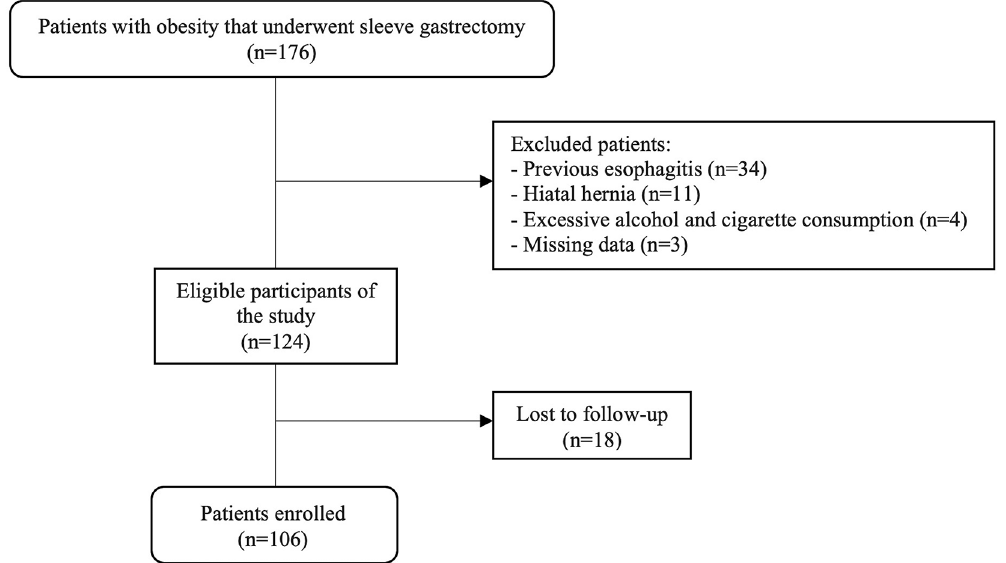
Figure 1. Flowchart of the study